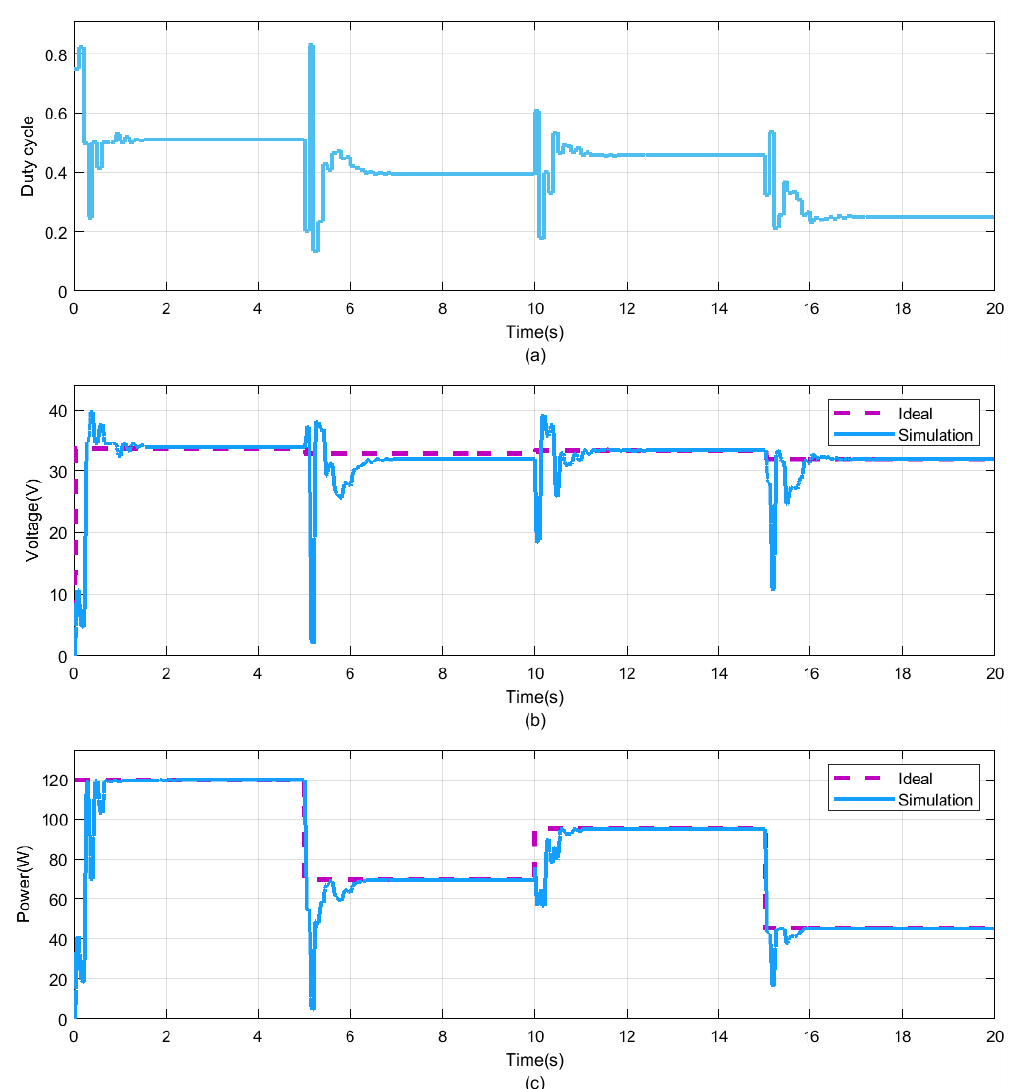
Figure 11. Simulation results under irradiance variation and Np = 2 given by the Improved Particle Swarm Optimisation (IPSO) algorithm: ( a ) Duty cycle, ( b ) Voltage under irradiance change, and ( c ) Power under irradiance